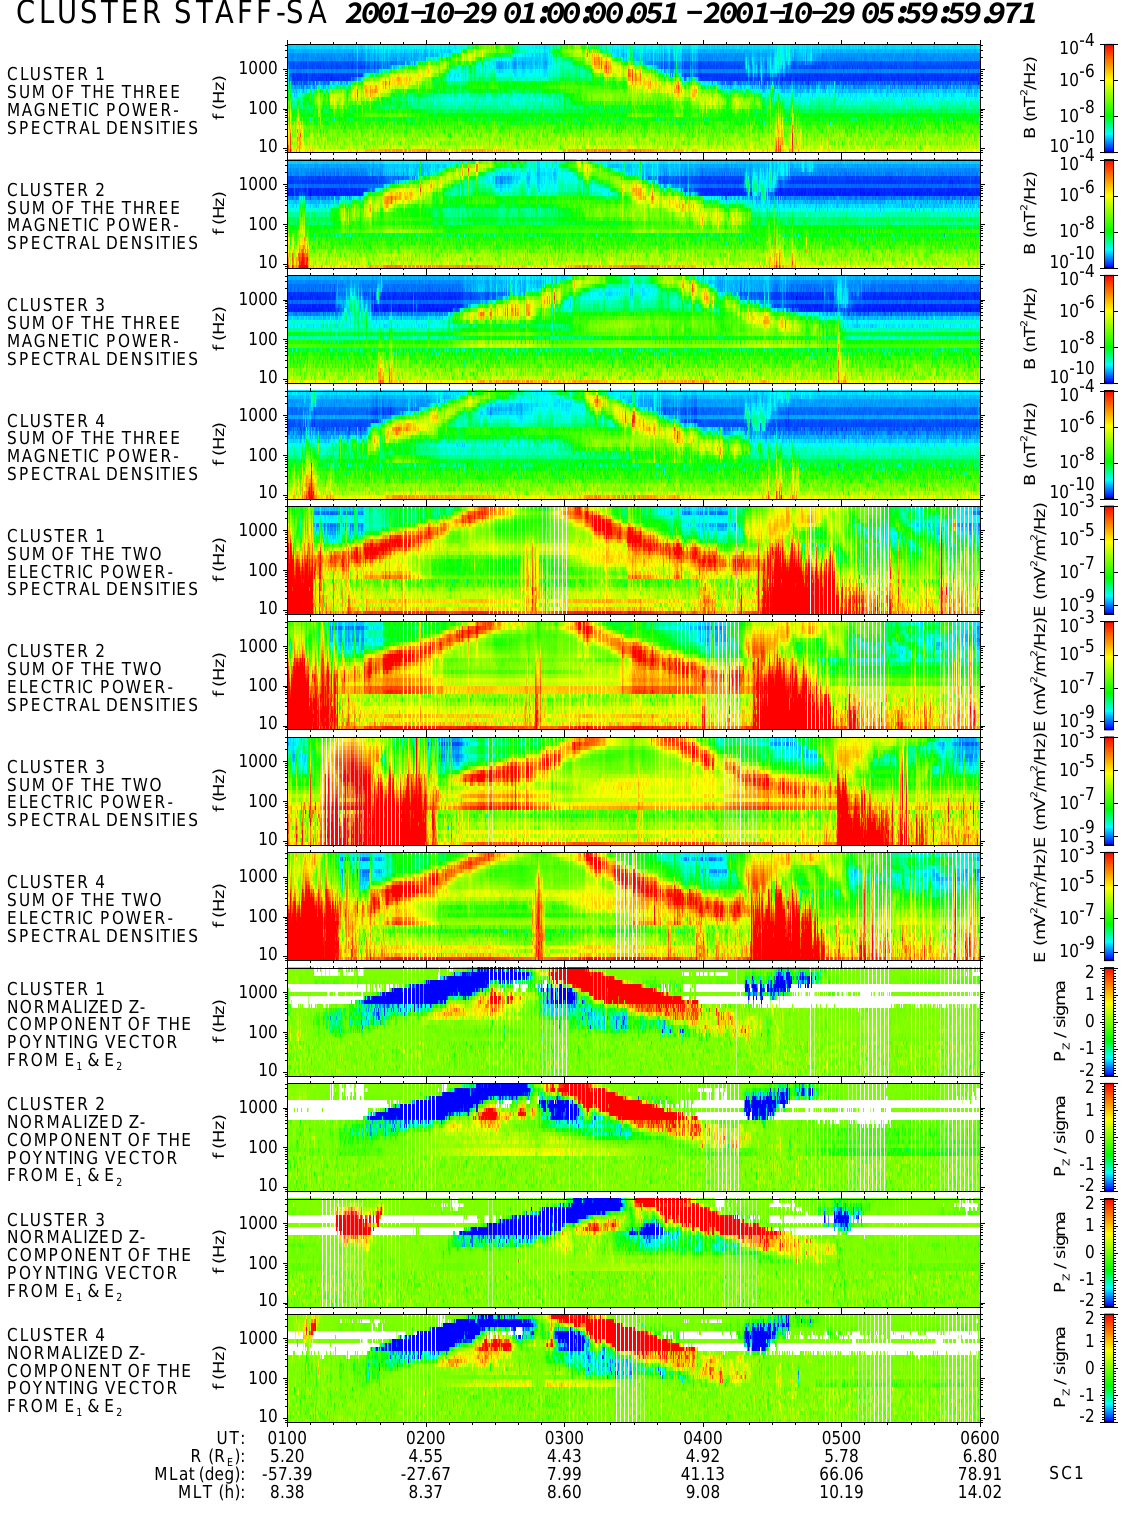
Fig. 1. Data recorded by the STAFF-SA experiment on 29 October 2001 between 01:00 and 06:00UT. From the top to the bottom, the panels represent the magnetic power-spectral density, the electric power-spectral density, and the direction of the z-component of the Poynting vector, for each SC, respectively. The intensities of the spectrograms and the reliability of the sense of the Poynting vector (see Parrot et al., 2003) are given by the colour-coded scales on the right. The geophysical parameters at the bottom are related to